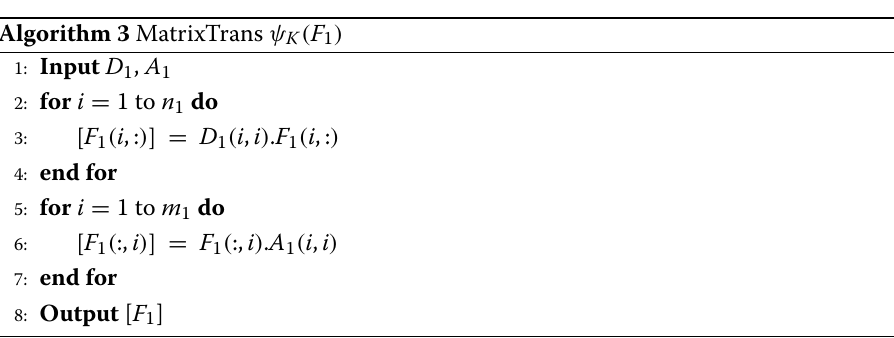
Algorithm 3 MatrixTrans ψ K ( F 1 )